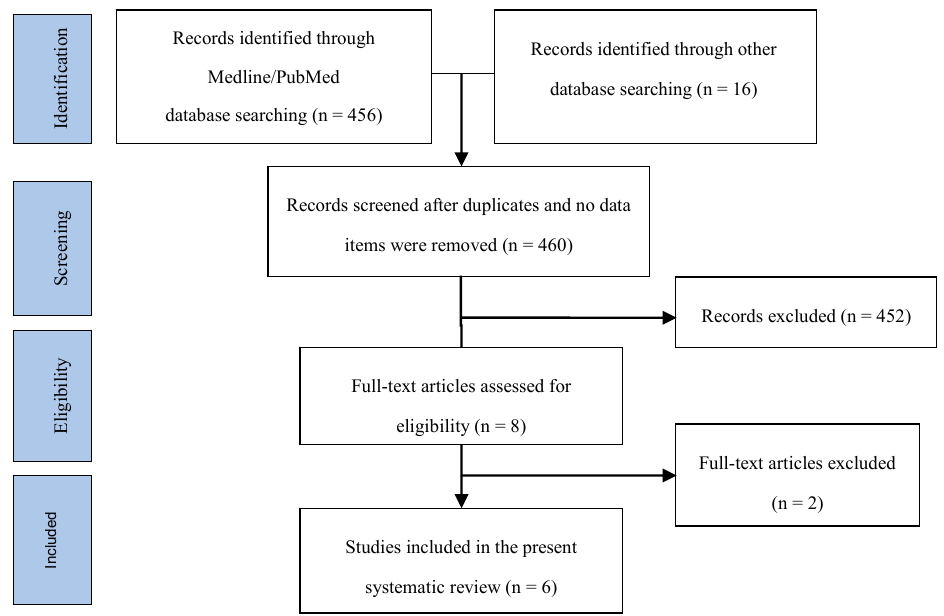
Figure 1. Flow diagram (PRISMA format) of the screening and selection process. The main characteristics of the included articles are reported in Table 2.